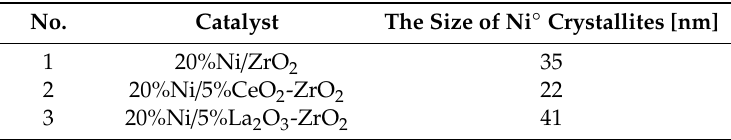
Table 2. Crystallite size of metallic nickel calculated from XRD measurements performed for spent Ni catalysts (after catalytic tests performed in the oxy-steam reforming of LNG process in the temperature range 400–700 ◦ C, a molar ratio between reagents was used: C:H 2 O:O 2 = 1:2.7:0.35, the total gas flow was 51 cm 3 / min).